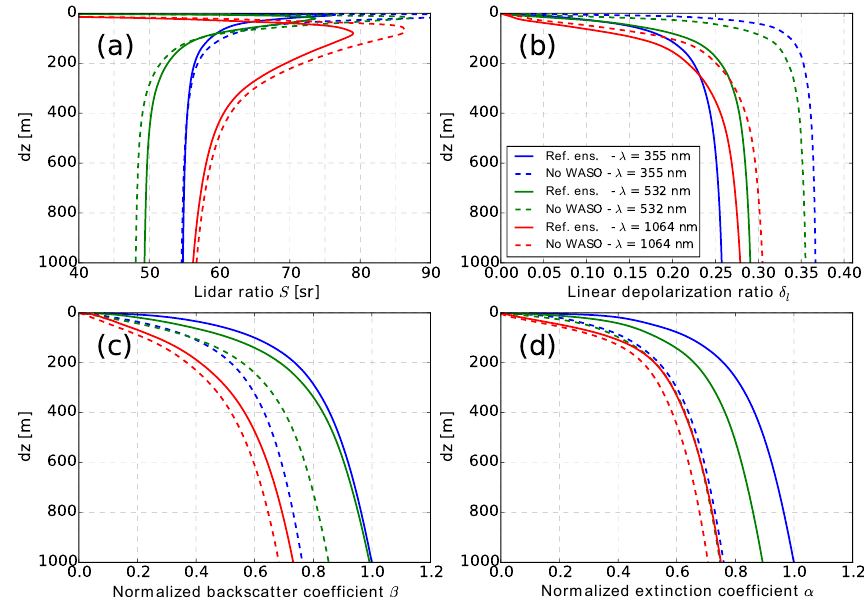
Figure 4. Optical aerosol properties of the upper 1km of the SAL for [H1, 5d] assuming the reference ensemble (solid lines) at three lidar wavelengths (indicated by color). β and α are normalized to the value of the reference ensemble at λ = 355nm and d z = 1000m. The dashed lines present profiles when WASO particles are removed from the reference ensemble.